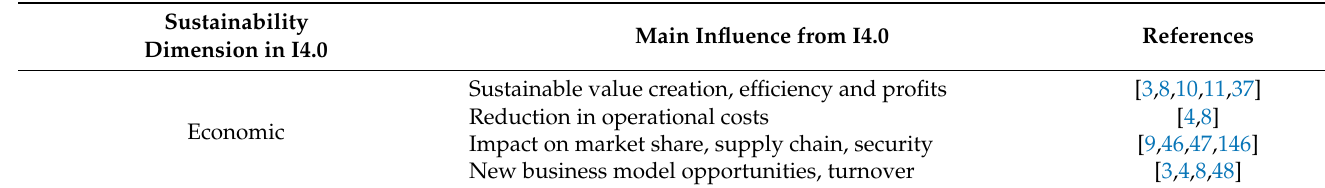
Table 2. Influence of Industry 4.0 technologies on economic sustainability.